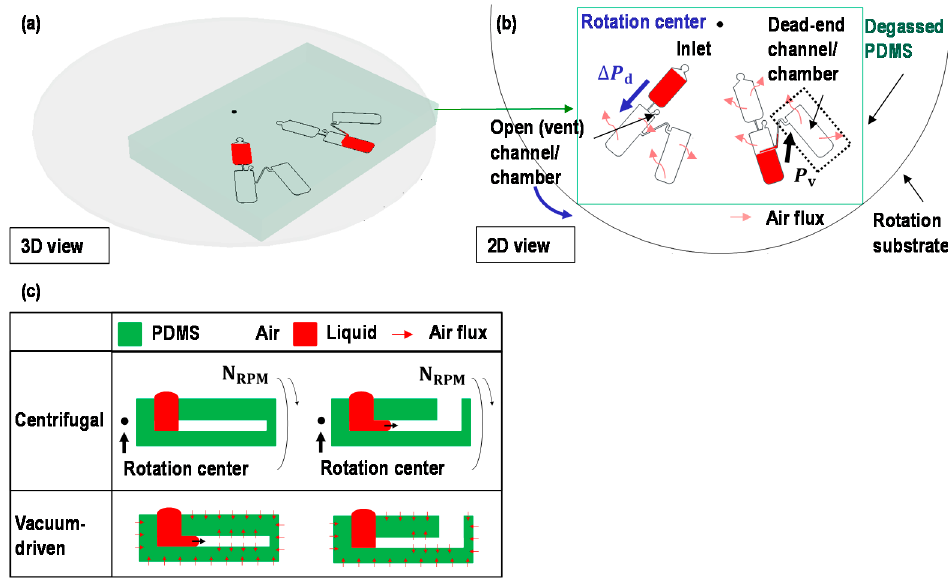
Figure 2. ( a ) The 3D and ( b ) 2D schematics of the operation principle using driving pressure by centrifugal force, Δ(cid:1842) (cid:2914) , or vacuum-driven pressure, (cid:1842) (cid:2932) . The centrifugal pressure allows the sample to be driven in a one-way direction, while the vacuum-driven force can be used for various direc- tions to drag the sample without any rotation. To switch the dominant forces between centrifugal force and vacuum-driven force to drive samples, the fluidic passage should be wisely